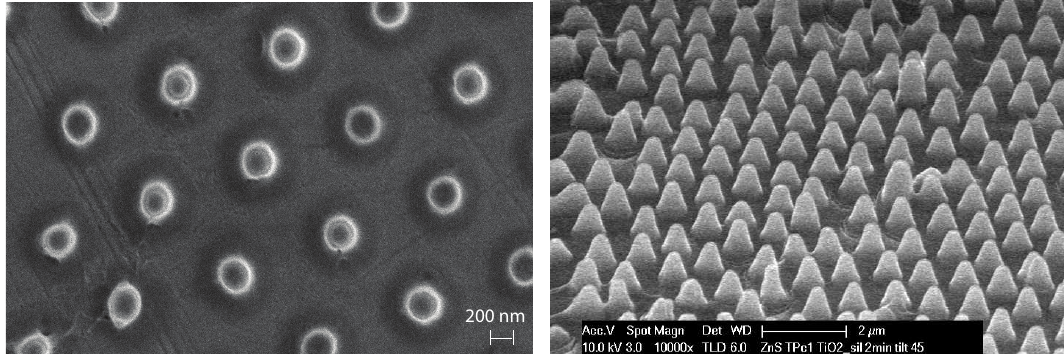
Figure 8. SEM photonic crystal nanostructure images before the implementation of the buffer layer. Left : Top view (scale bar: 200 nm), Right : Side view (scale bar: 2000